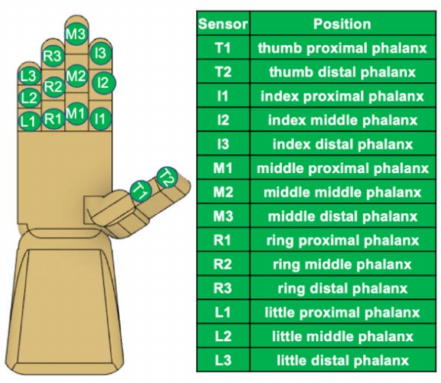
Figure 1. Fabricated force measurement glove: ( a ) glove with FlexiForce sensors; ( b ) glove with FlexiForce sensors and membranes viewable; ( c ) printed circuit board (PCB) to interface the sensors; ( d ) PCB with attachments of FlexiForce sensors (green arrow), 1 M Ω resistor (red arrow), and output wire (orange arrow).